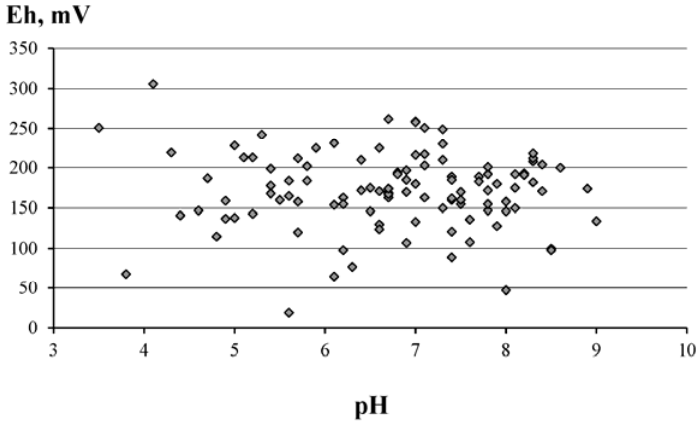
Figure 3. pH vs. redox potential (Eh) plot for the studied area.